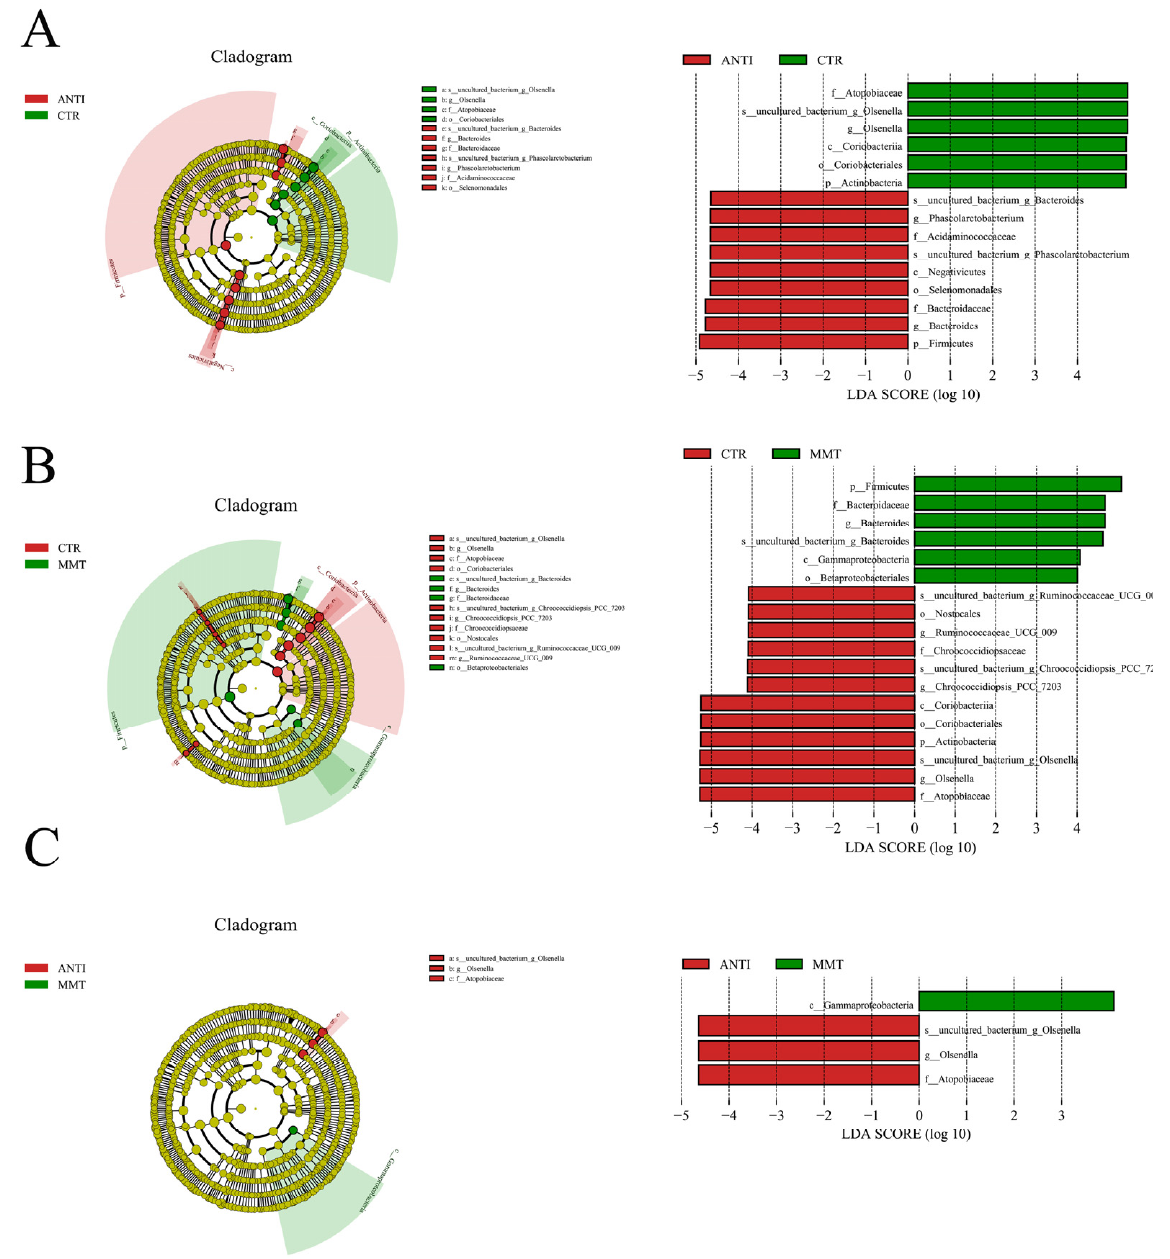
Figure 3. LEfSe cladogram and LEfSe bar: ( A ) CTR vs. ANTI; ( B ) CTR vs. MMT; ( C ) ANTI vs. MMT.